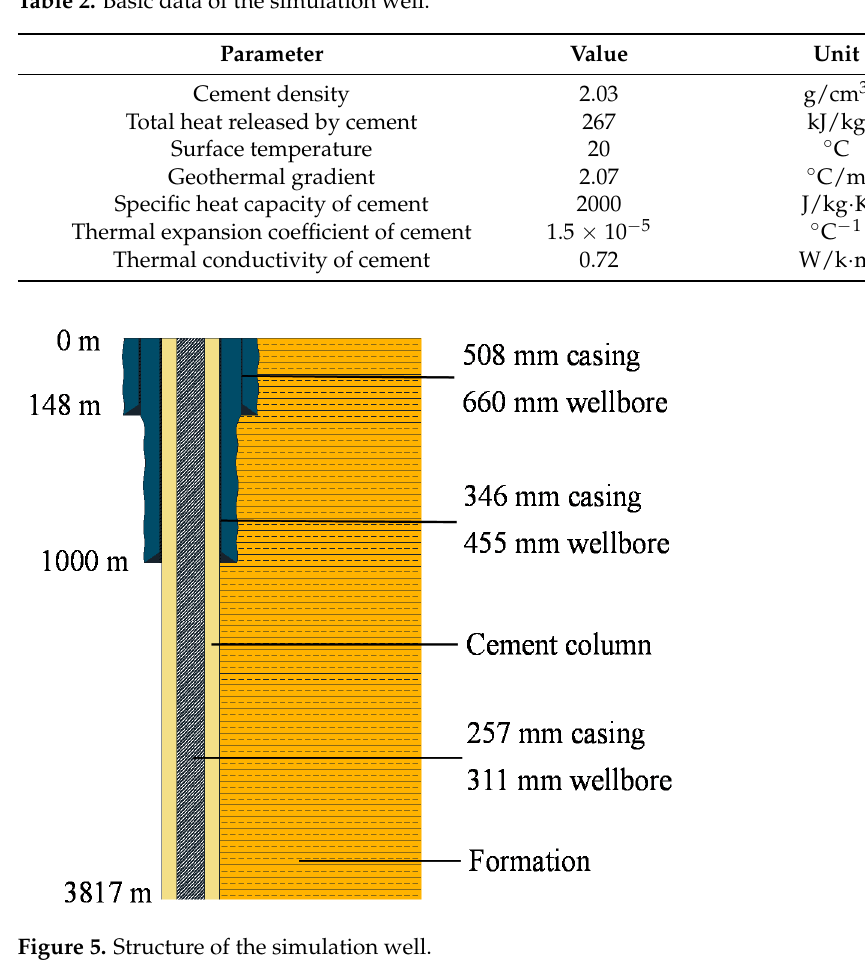
Table 2. Basic data of the simulation well.